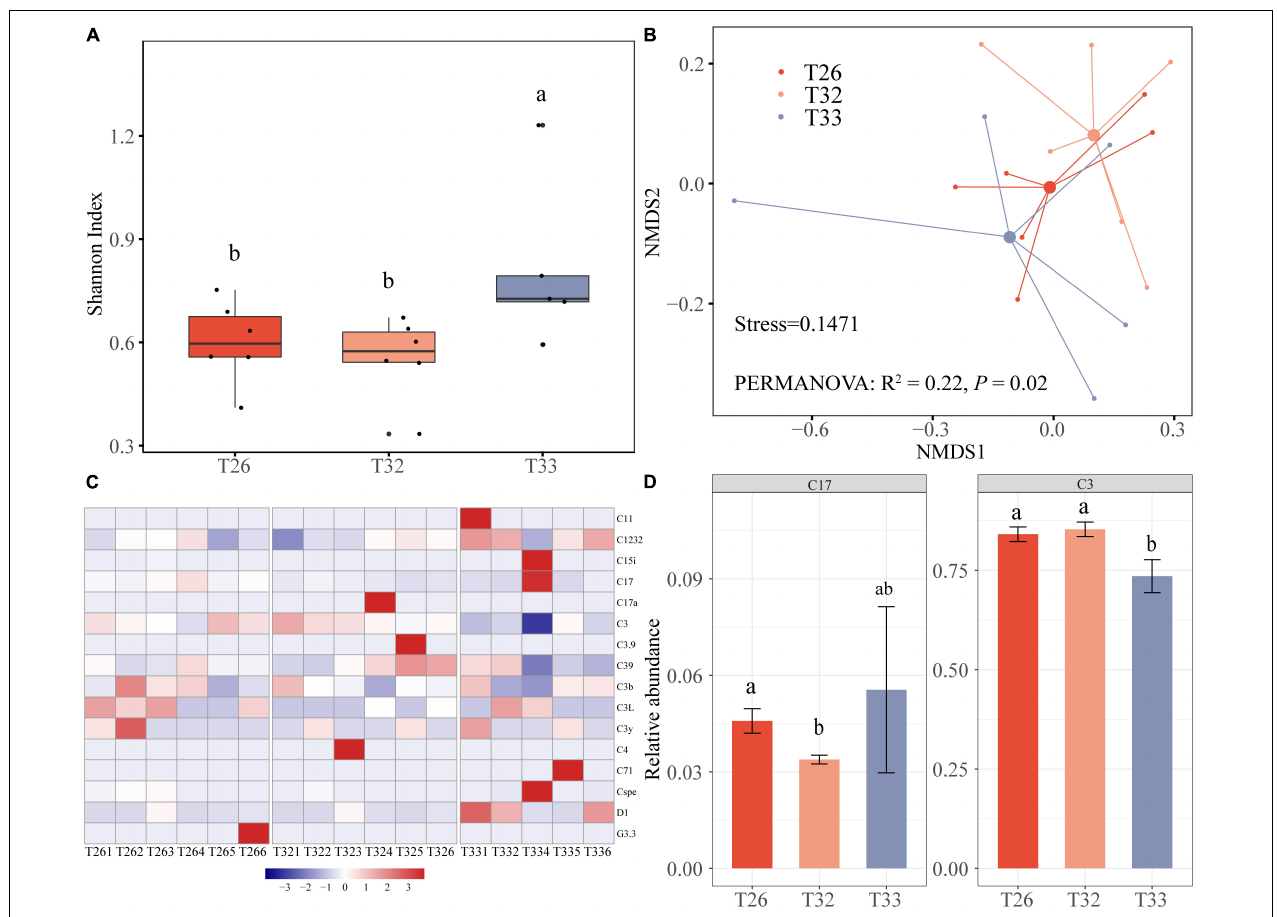
FIGURE 3 | The diversity and the community of Symbiodiniaceae. (A) Shannon index of bacteria. (B) NMDS analysis performed on community composition dissimilarities (Bray-Curtis) across different temperatures. (C) Symbiodiniaceae composition. (D) Dominant Symbiodiniaceae with a difference at different